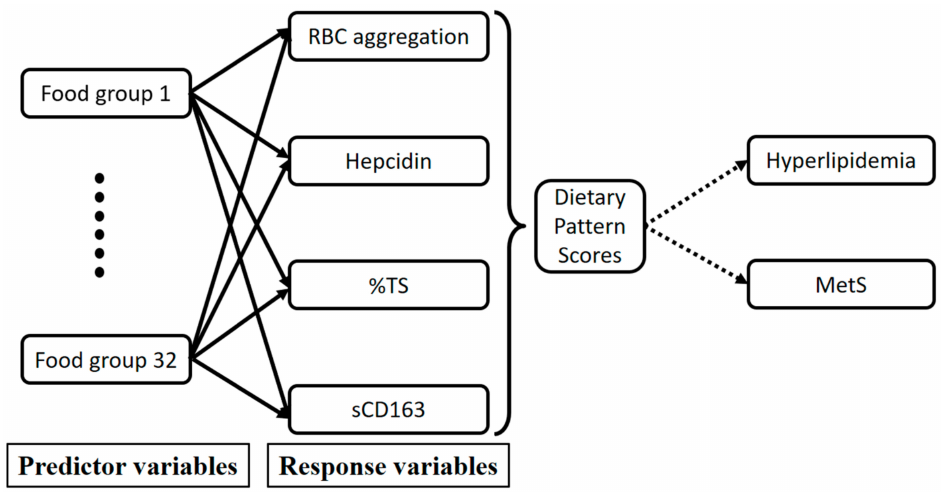
Figure 1. Directed acyclic graph of the reduced rank regression (RRR) conceptual framework. RBC: red blood cell; %TS: serum transferrin saturation; MetS: metabolic syndrome; sCD163: soluble cluster of differentiation